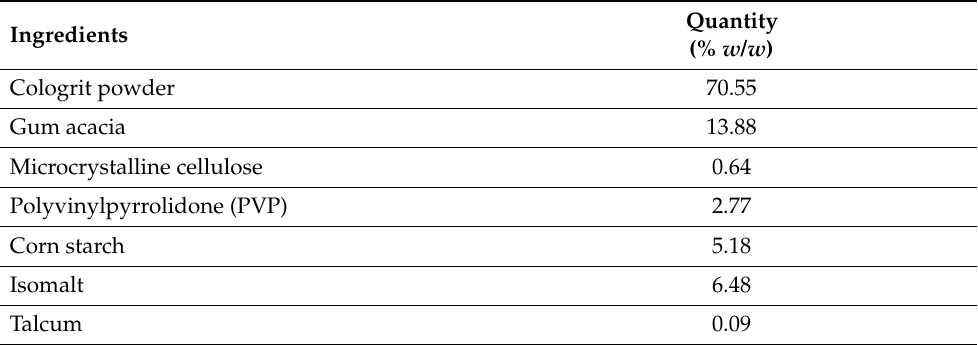
Table 3. Cologrit composition per 540 mg tablet.